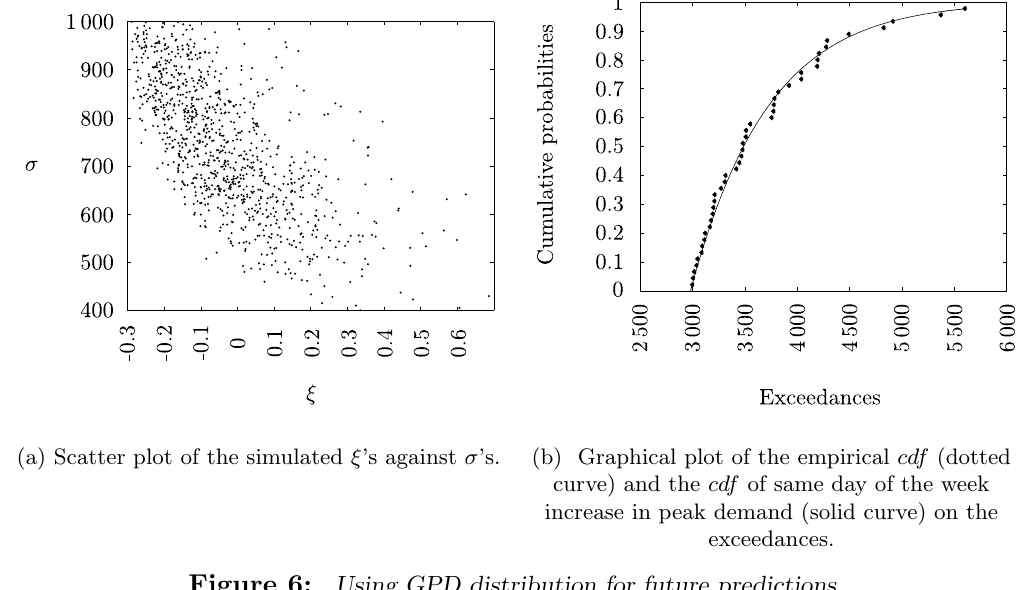
Figure 6: Using GPD distribution for future